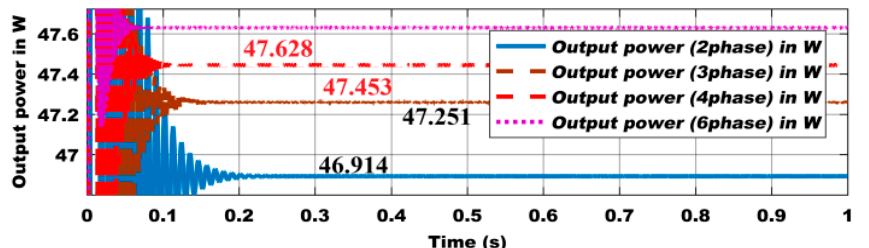
Figure 4. Output power comparison of MPIBC at duty cycle of 50%.